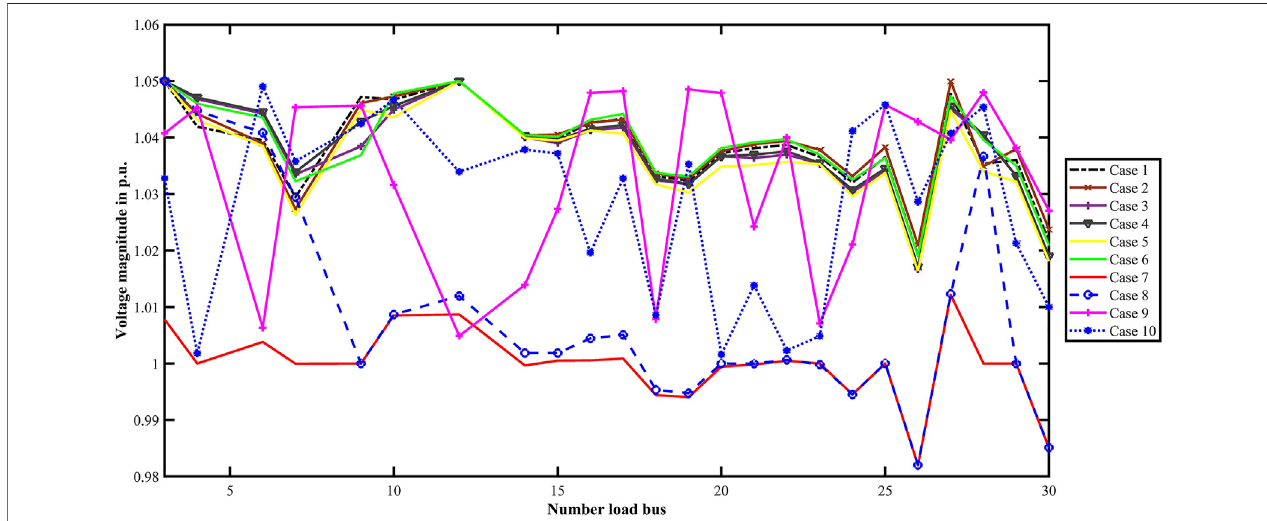
FIGURE 7 | Voltage pro fi le of the system for ten cases obtained by the proposed